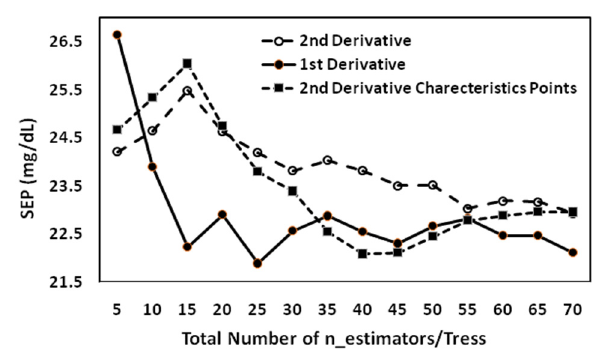
Figure 12. SEP of different Random Forest Regression (RFR) models against the number of estima- tor tress.